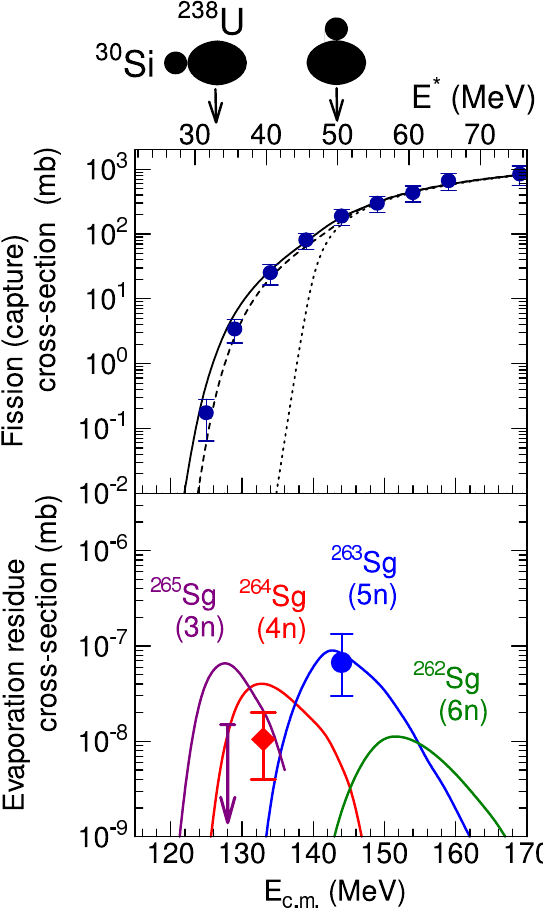
Fig. 1. Fission (upper part) and evaporation residue cross-sections (lower part) of the reaction 30 Si + 238 U → 268 Sg ∗ as function of the center-of-mass energy E c . m . and excitation energy E ∗ . The fission cross-section is obtained in this experiment. The ER cross-section data were from [5]. Curves are the model calculations (see